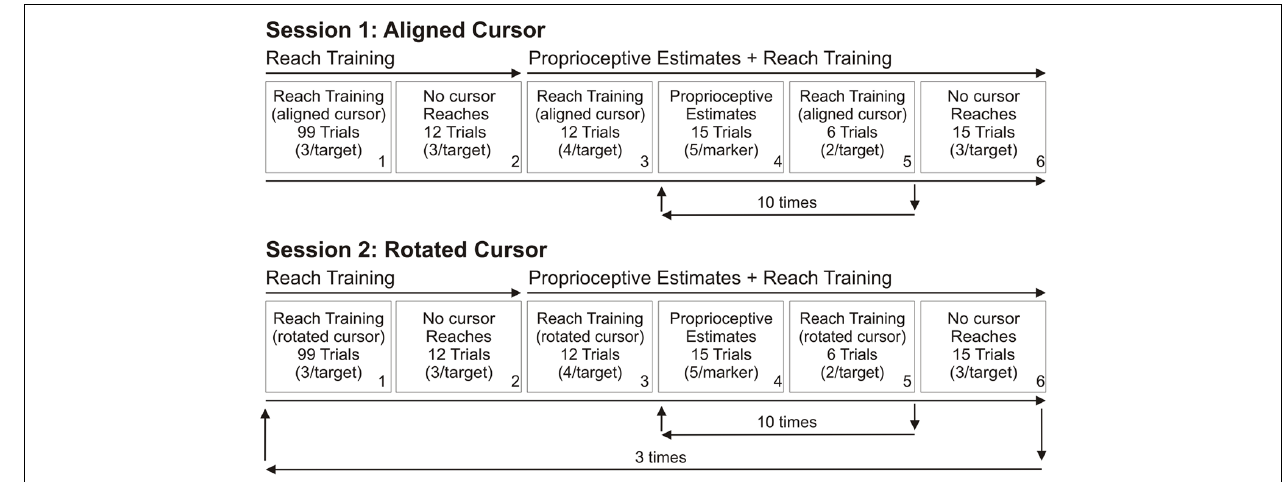
served as a baseline. Bottom row: Session 2. In the second testing session, the tasks (Boxes 1–6) were similar to those in Day 1, except the terminal cursor feedback was gradually rotated 30 ◦ CW from their actual hand position, reaching its full rotation of 30 ◦ by the 41st trial, and remaining at this rotation for the remainder of the trials (Box 1) and subsequent reach training trials (Boxes 3 and 5) and the additional training sets. These tasks (Boxes 1–6) constitute one block, and were repeated twice more for a total of three